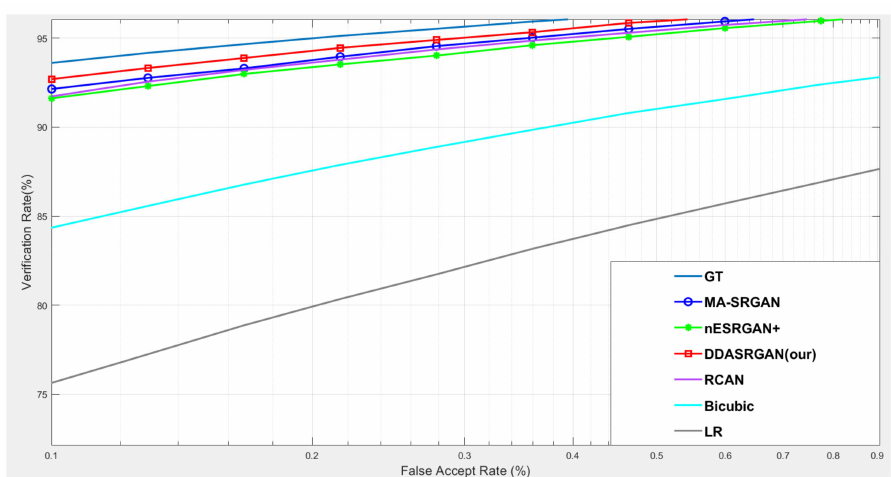
Figure 13. Detailed comparison of ROC curves for each SR model on the CASIA-Iris dataset. In the detailed comparison, we can find that the LR images downgrade the recognition accuracy almost 20% when FAR = 0.1%. The various SR approaches mitigate this gap, and the proposed method achieves the best performance among those approaches.